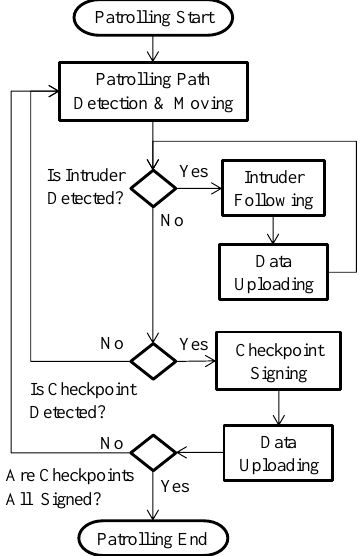
Figure 3. Flowchart showing the process of autonomously patrolling a site.